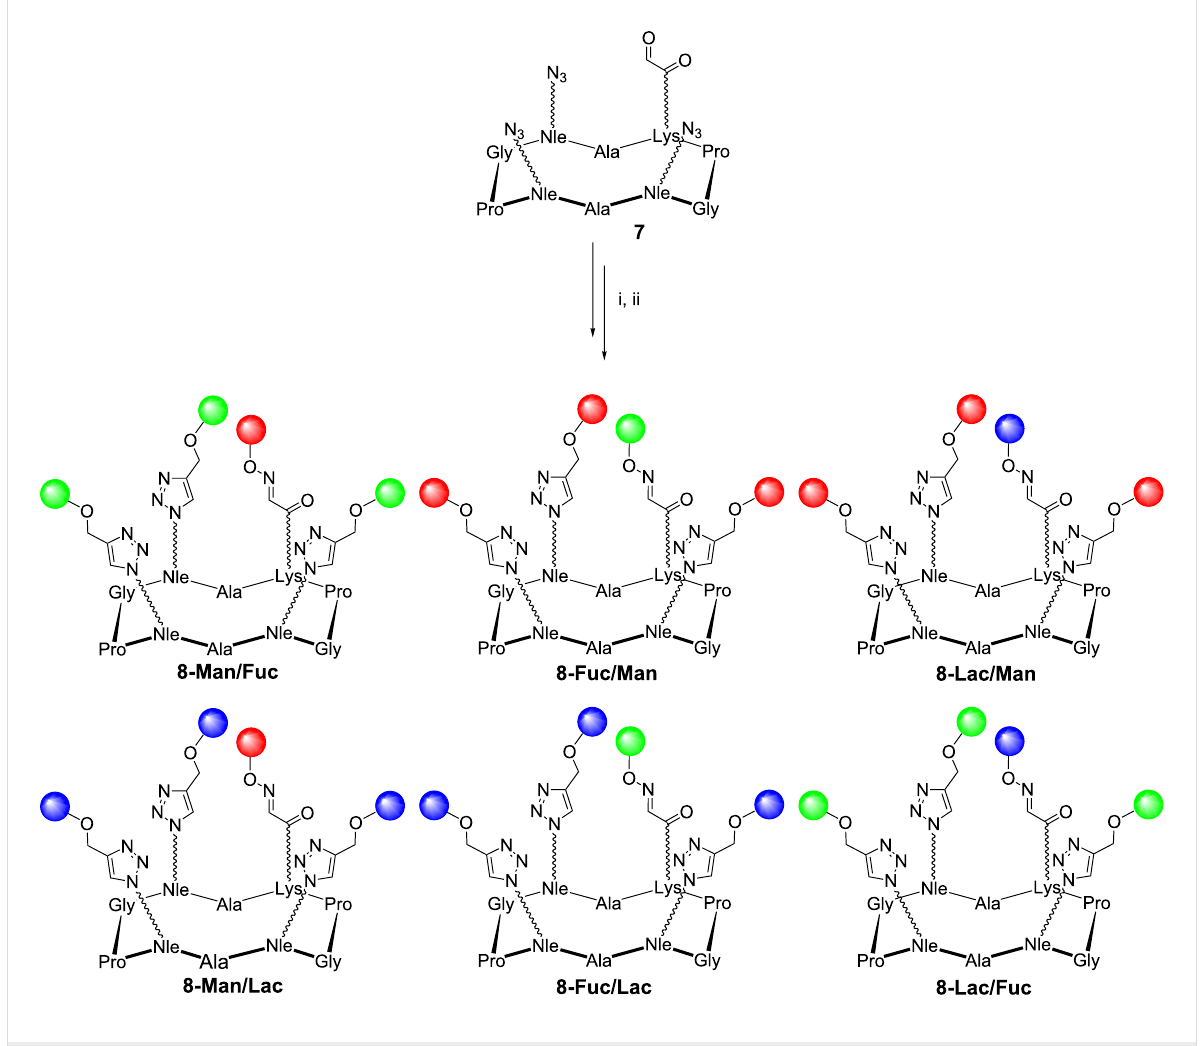
Scheme 2: Synthesis of heteroglycoclusters of the 3:1 series. Reagents and conditions: (i) 1a , 2a or 3a , 0.1% TFA in H 2 O; (ii) 1b , 2b or 3b , Cu micro- powder, t -BuOH, AcONH 4 100 mM pH 7.4 (1:1, v / v ).